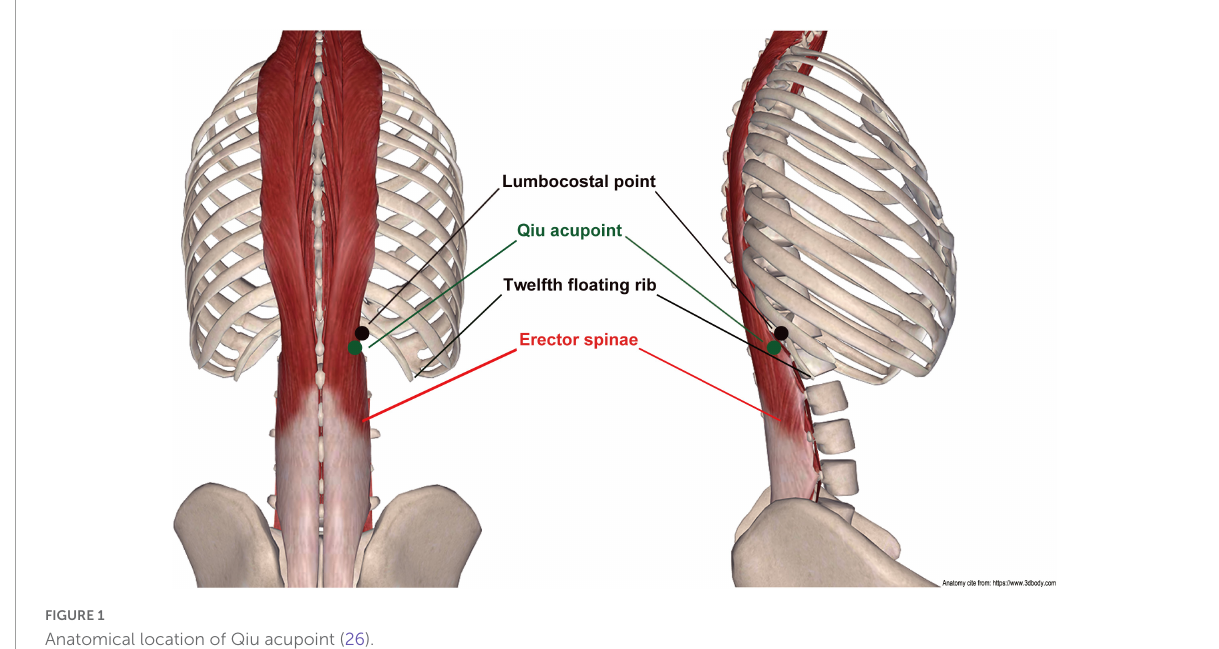
FIGURE1 Anatomical location of Qiu acupoint (26).